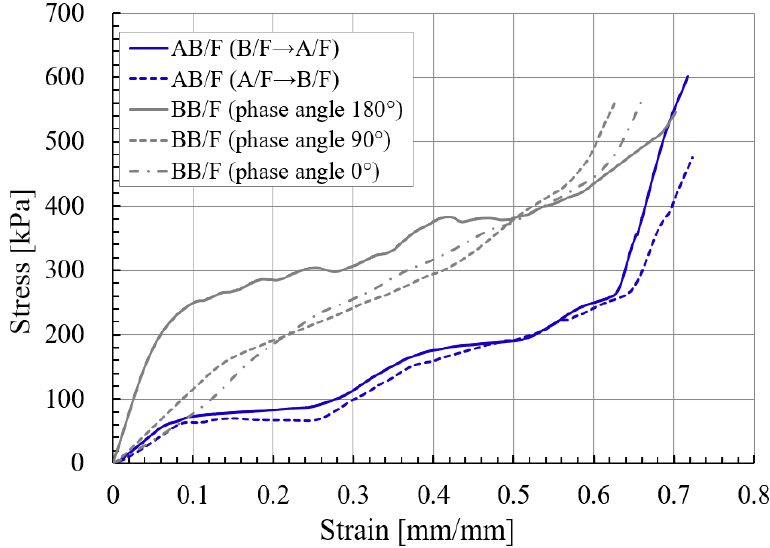
Figure 6. SS curves of the DW corrugated paperboard obtained using FEA.